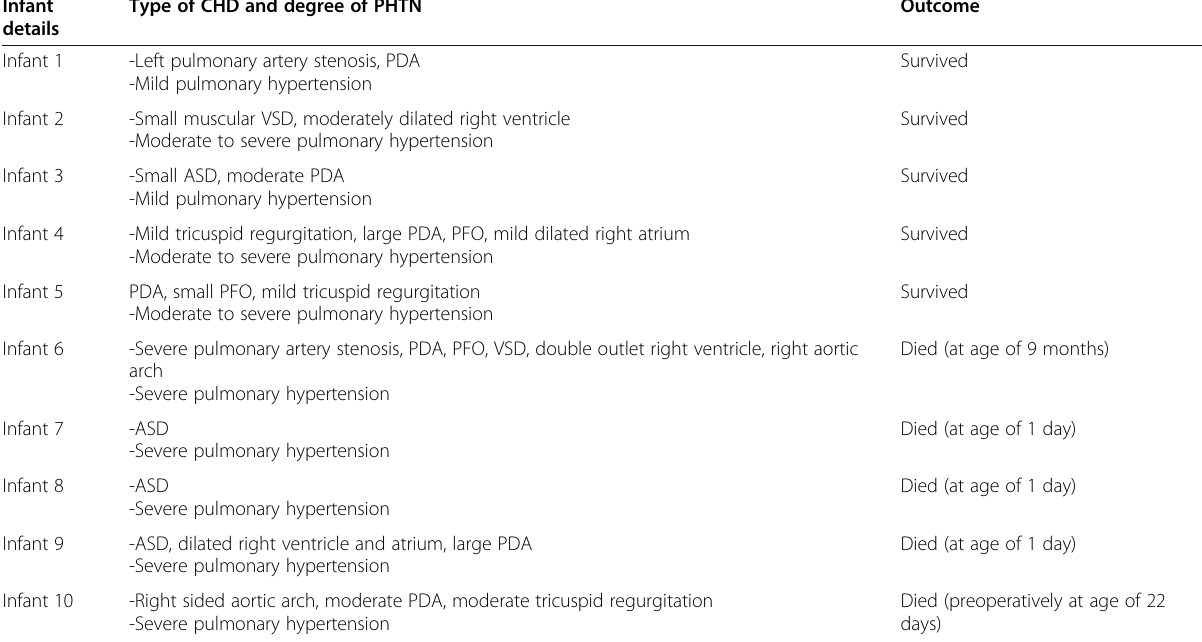
Table 2 Spectrum of congenital heart disease (CHD), degree of pulmonary hypertension (PHTN), and patient outcome Infant